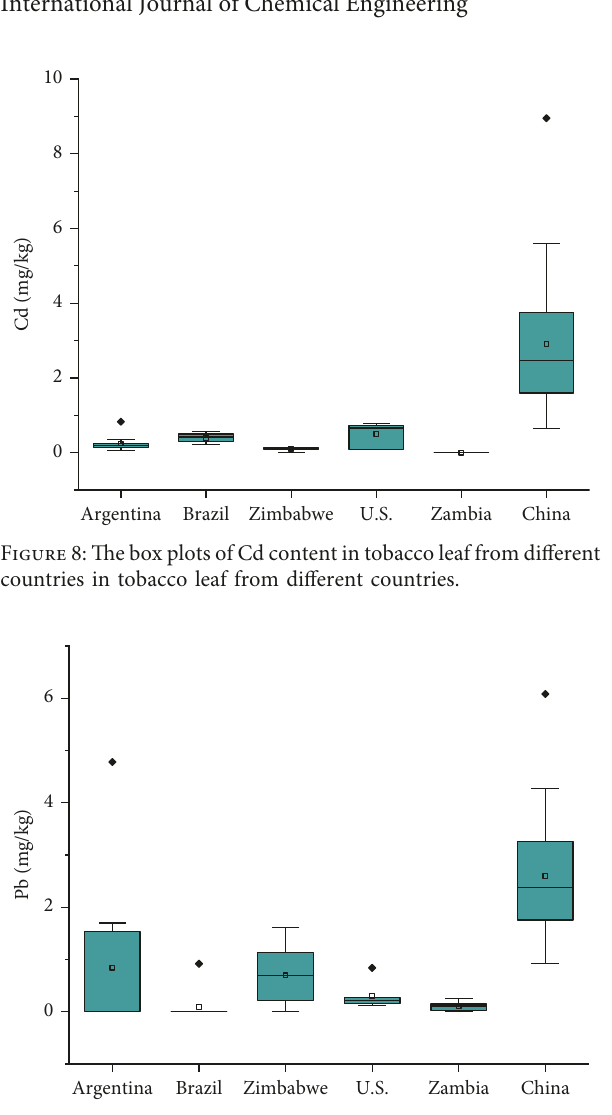
Figure 9: The box plots of Pb content in tobacco leaf from different